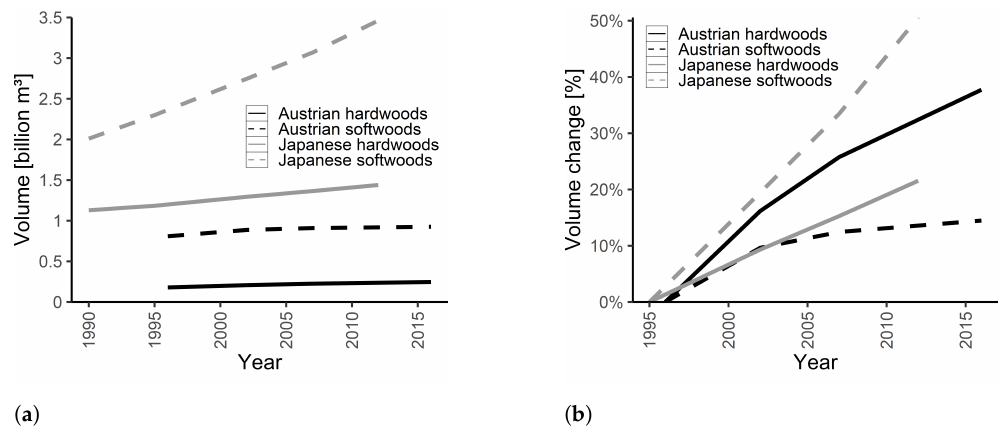
Figure 4. Total volume ( a ) and volume change since 1995 (Japan) and 1996 (Austria) ( b ) of hardwoods and softwoods according to data from the Austrian National Forest Inventory (1996, 2002, 2009, 2018) and Forest Agency (2019b).